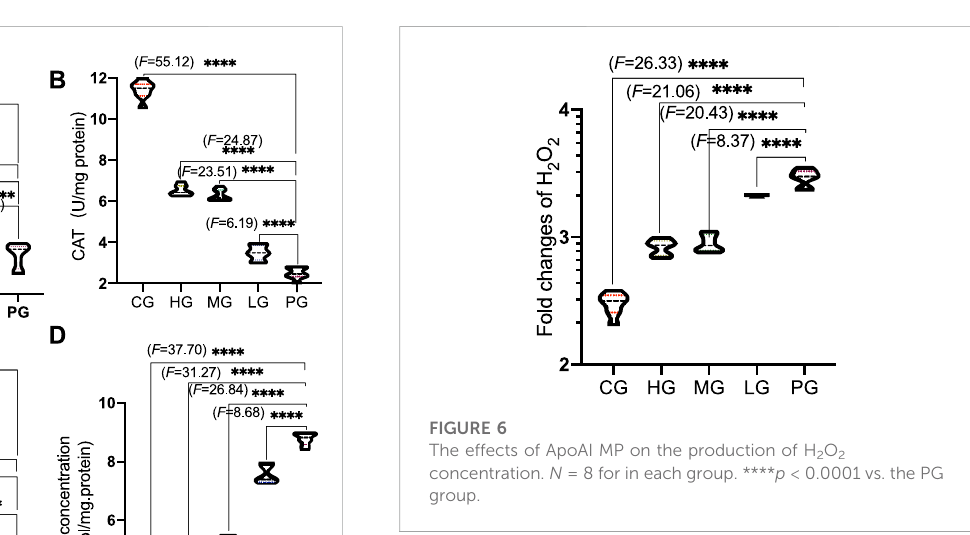
(Figure 5B) and GSH-Px (Figure 5C) except of the LG group and reduced MDA concentration (Figure 5D, p < 0.0001). It shows that ApoAI MP can increase the level of antioxidant factors and reduce